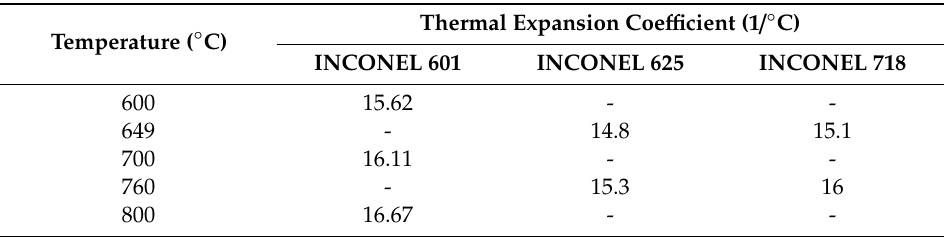
Table 4. Thermal expansion coe ffi cient of INCONEL alloy